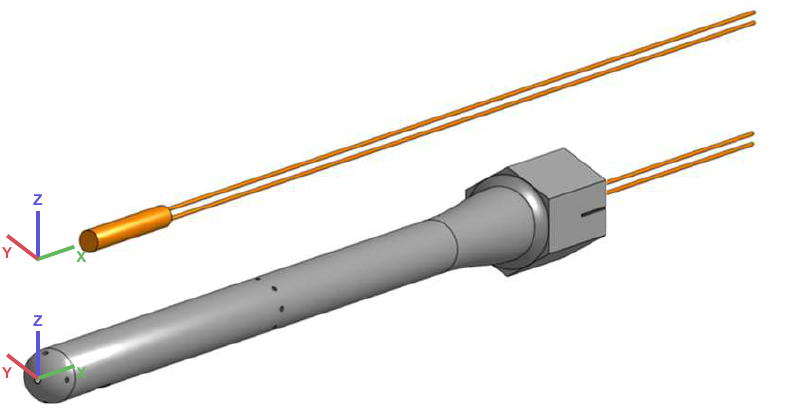
Figure 7. CAD model for the five-hole probe and the heating